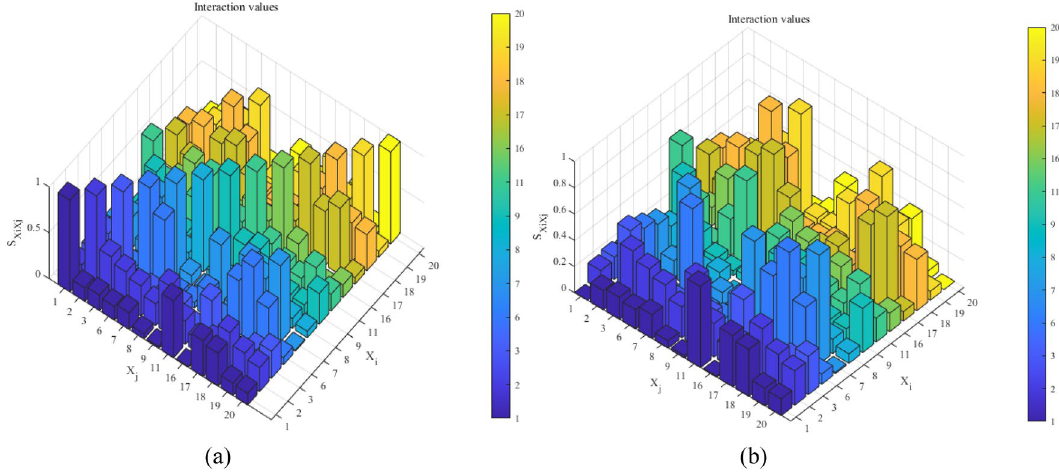
Figure 15. Comparison of the second-order interaction effect